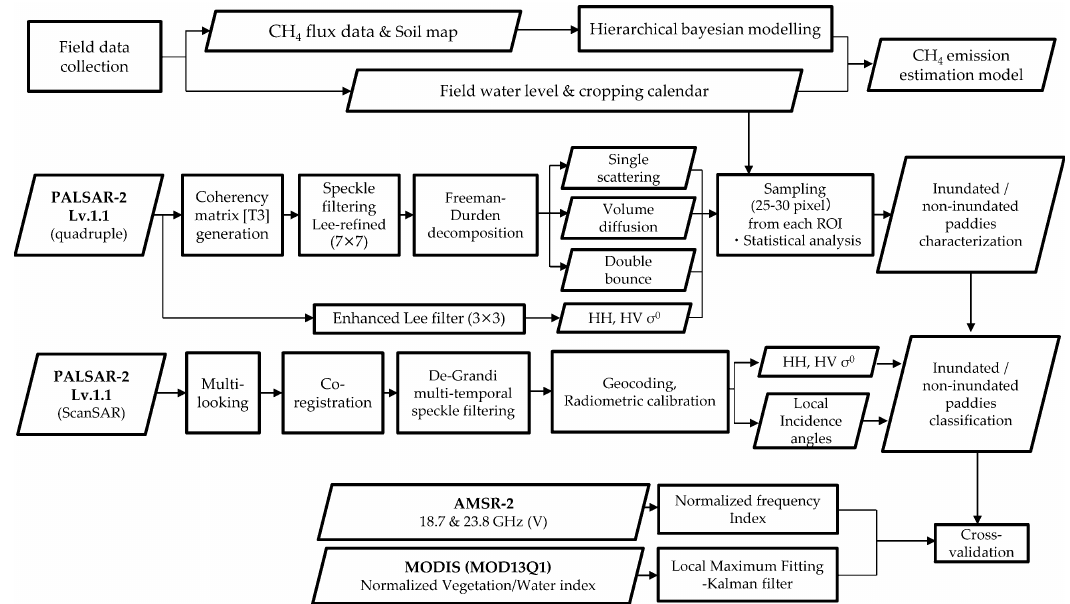
Figure 1. Flowchart of the study outlining the data, processing, and analysis. PALSAR-2, AMSR-2, MODIS, and HH HV σ 0 refer to the Phased Array type L-band Synthetic Aperture Radar, Advanced Microwave Scanning Radiometer-2, MODerate resolution Imaging Spectroradiometer, and the backscattering coefficient of HH/HV microwaves, respectively.